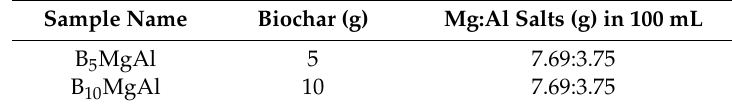
Table 1. Composition of biochar–MgAl